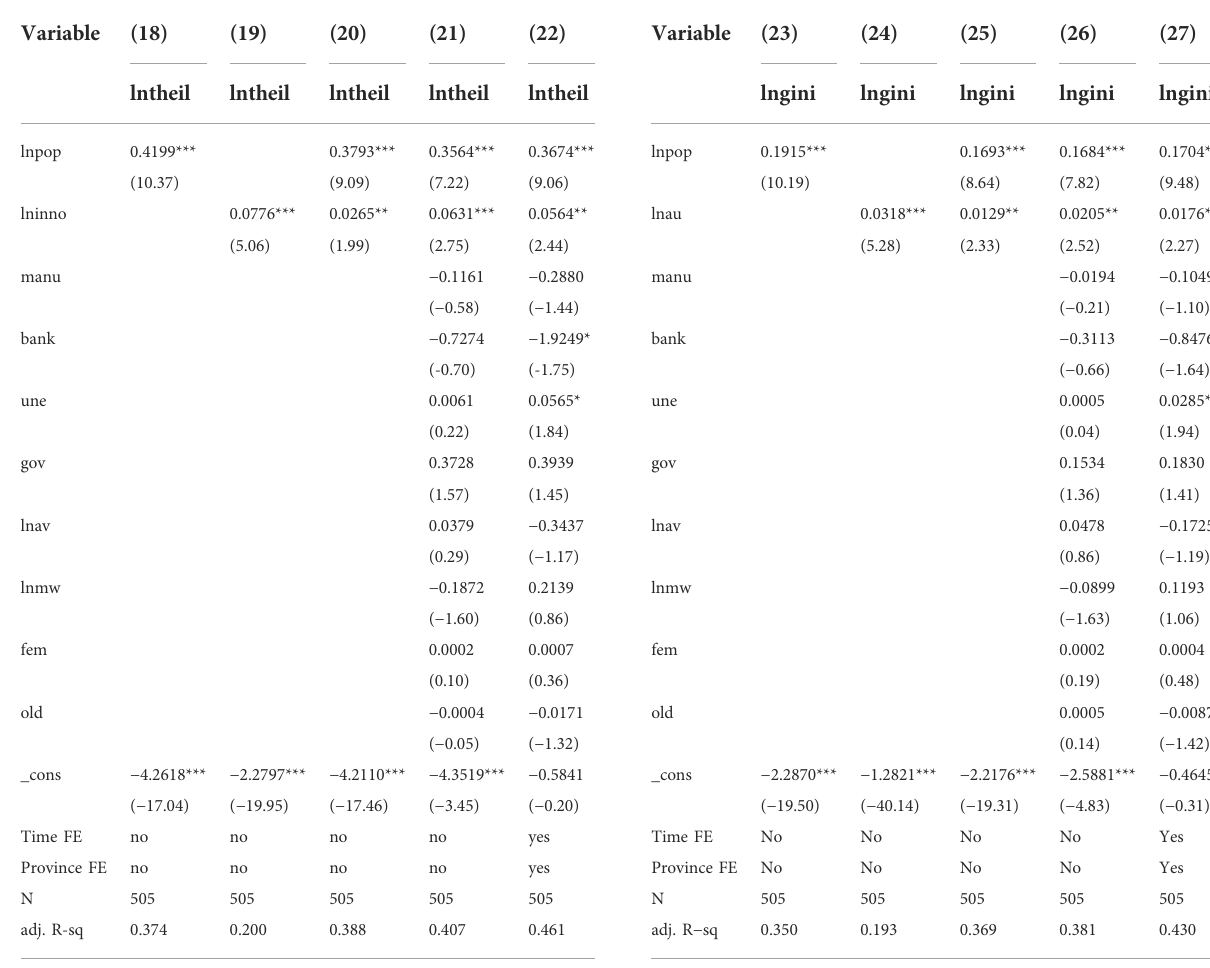
TABLE9Robustnesstests:alternativeproxyvariablefortechnological